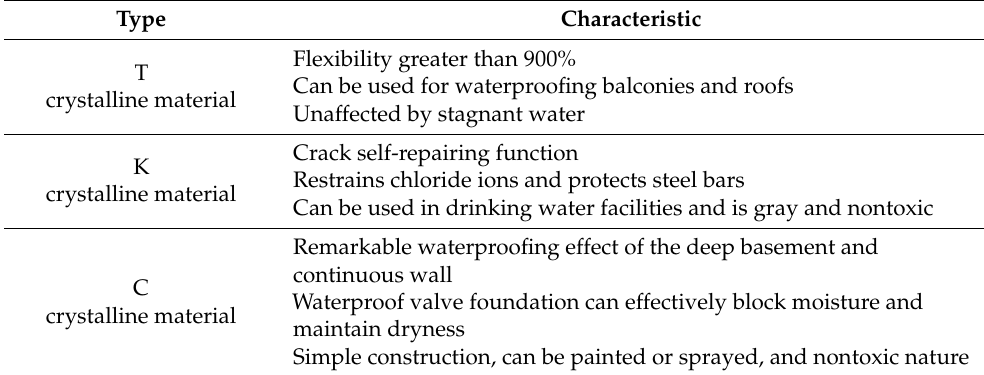
Table 3. Description of the adopted inorganic crystalline